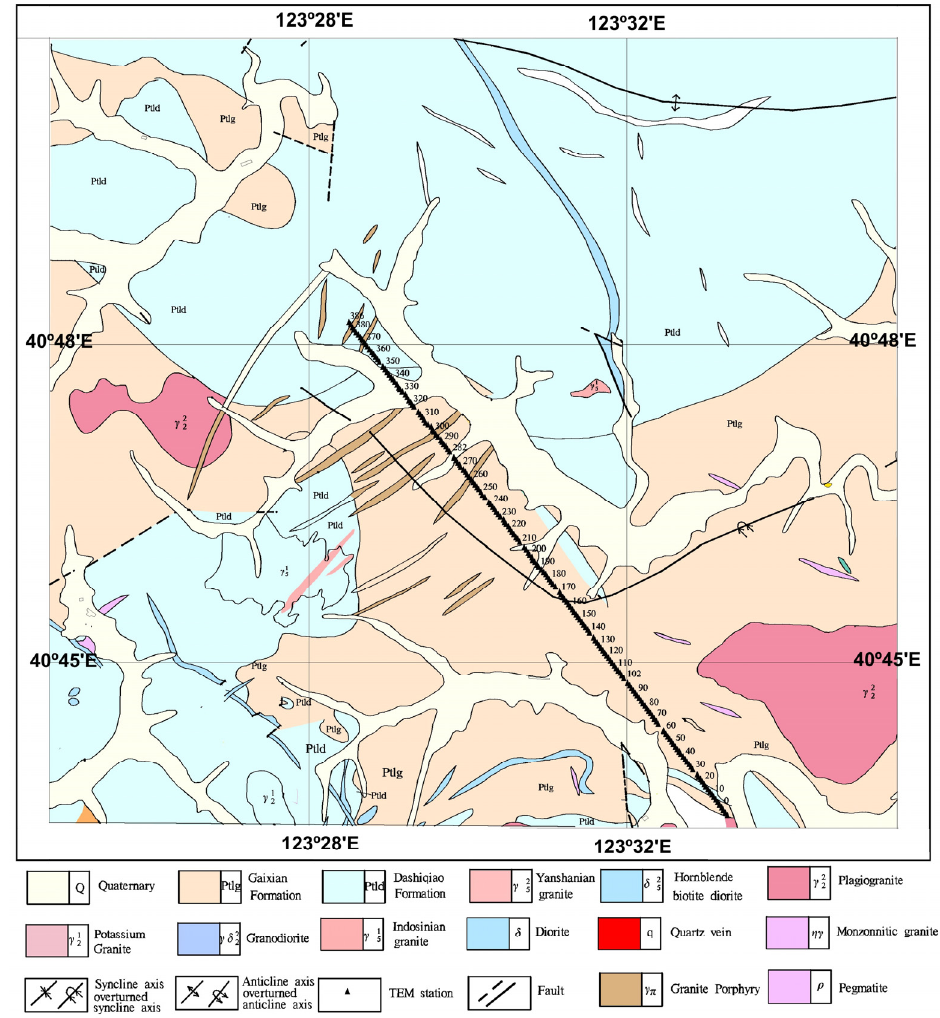
Figure 2. Geological map of Qingchengzi orefield and TEM stations (modified from [16]).